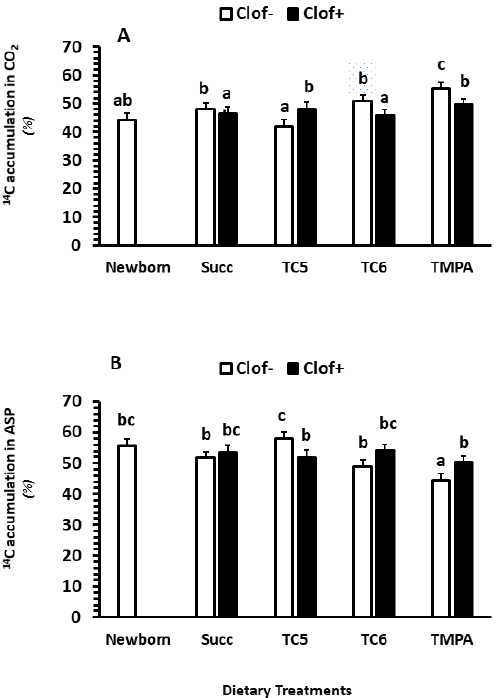
Figure 2. The effect of clofibrate and MCTs on the distribution (% of the total intestinal fatty acid oxidation) of CO 2 ( A ) and ASP ( B ). Clof: clofibrate; Succ: Succinate+glycerol; TC5: tri-valerate; TC6: tri-hexanoate; TMPA: tri-2-methylpentonoate; ASP: acid soluble products. abc denotes significant ( p < 0.05) differences between groups. Values are least square means (n = 6) ± SEM (Standard error means).